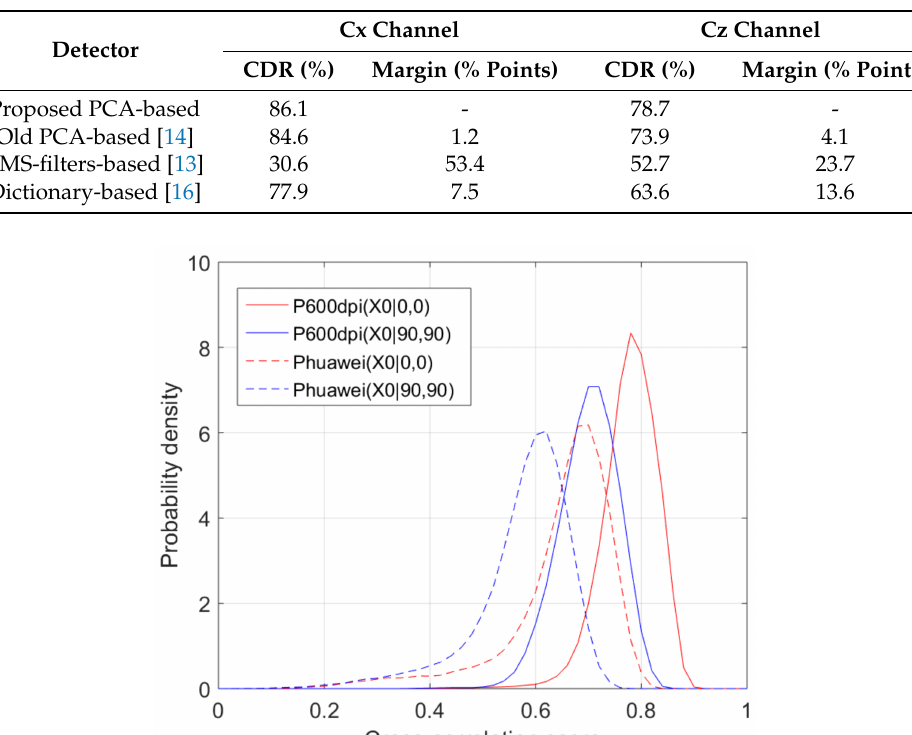
Table 4. CDR for different detectors using the Huawei-captured testing images, and statistically significant improvement of the proposed PCA-based detector.